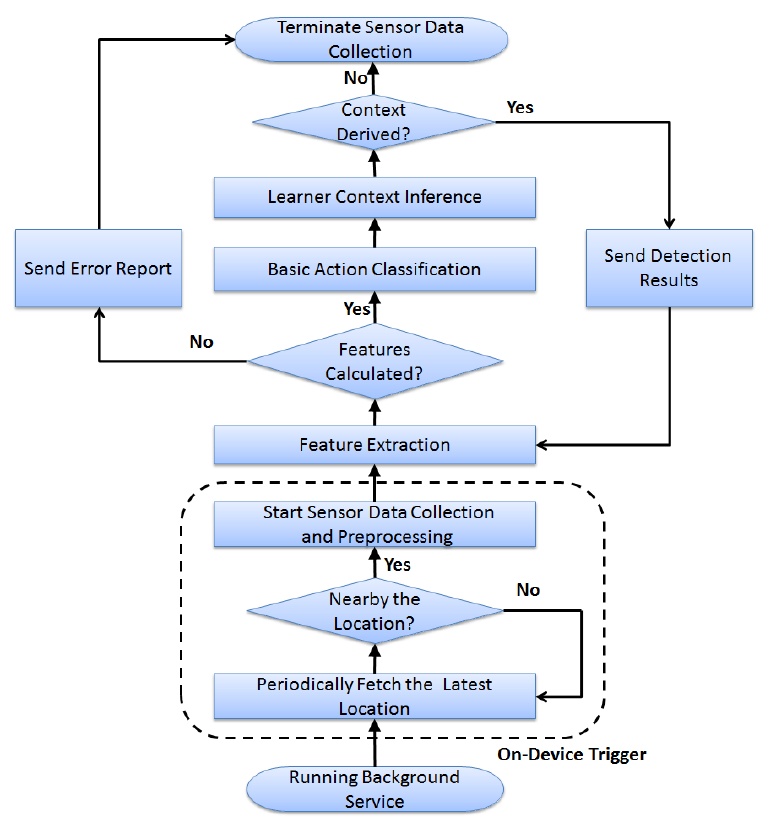
Figure 2. Learner context collector